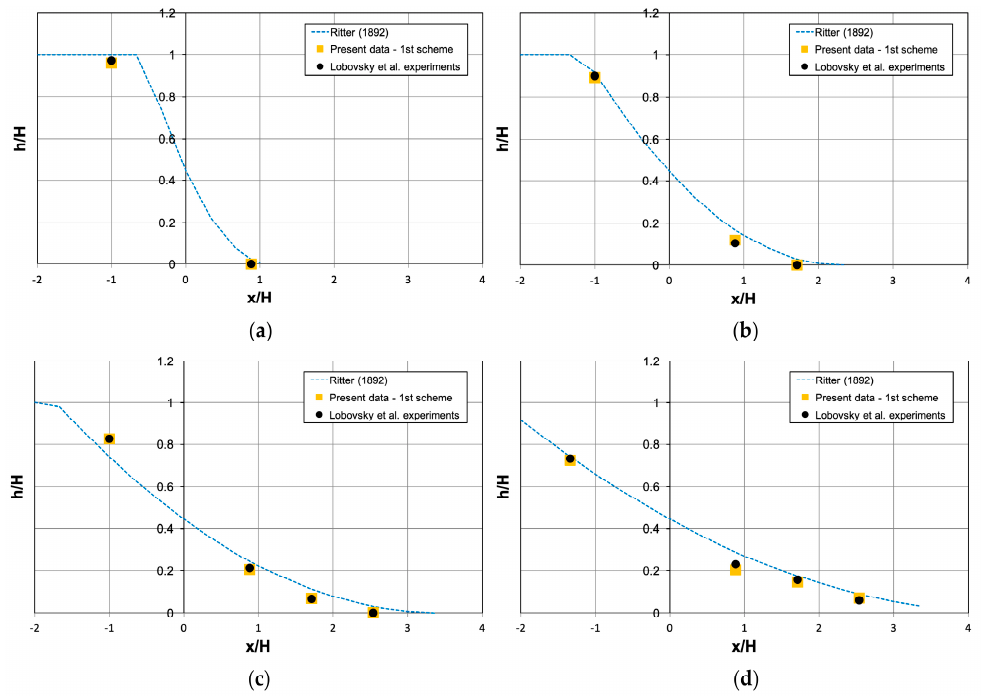
Figure 4. Comparison between the experimental and the numerical water level elevations at locations: ( a ) H 1 ; ( b ) H 2 ; ( c ) H 3 ; and ( d ) H 4 with the Ritter theoretical solution at t = 0.1 s, t = 0.2 s, t = 0.3 s, and t = 0.4 s, until the arrival of the secondary wave.